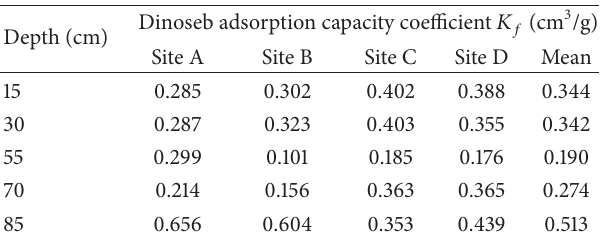
Table3:Averagedadsorptioncapacitycoefficient 𝐾 𝑓 valuesofdino- seb obtained from batch experiments.